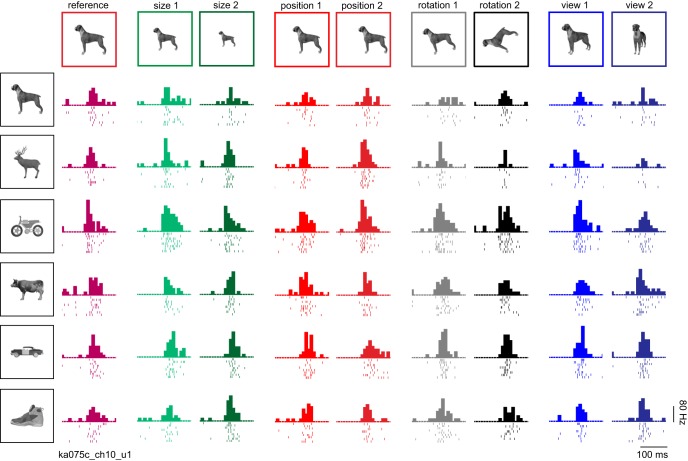
Example IT neuron. Responses of an example IT neuron for a subset of six objects across all transformations (levels 1 and 2 for size, position, rotation, and view). In each subplot, the starting point is the image onset time, each row is a single trial and ticks indicate spike times. The histogram above the raster represents the firing rate in 20-ms bins.